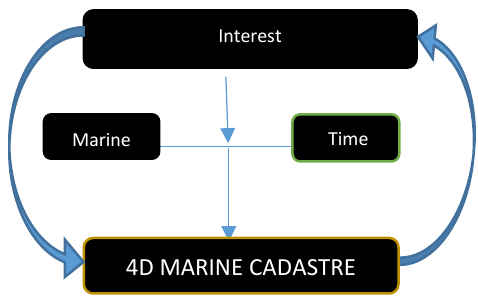
Figure 2. Conceptual Framework For The Proposed 4d Marine Cadastre